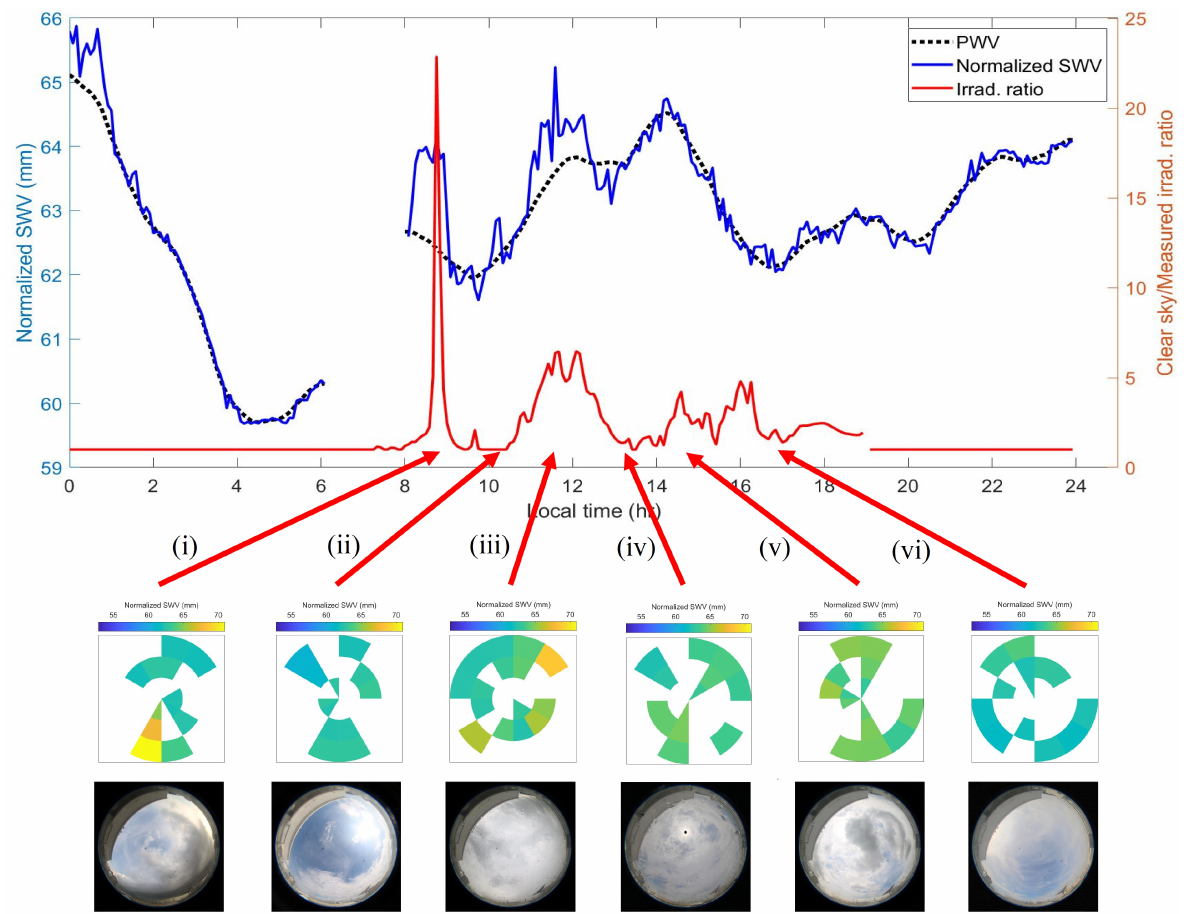
Figure 13. Time series of PWV , normalized SWV , and clear sky to measured solar irradiance ratio on 13 May 2016. Also shown are the spatial plots of normalized SWV and sky images at various local